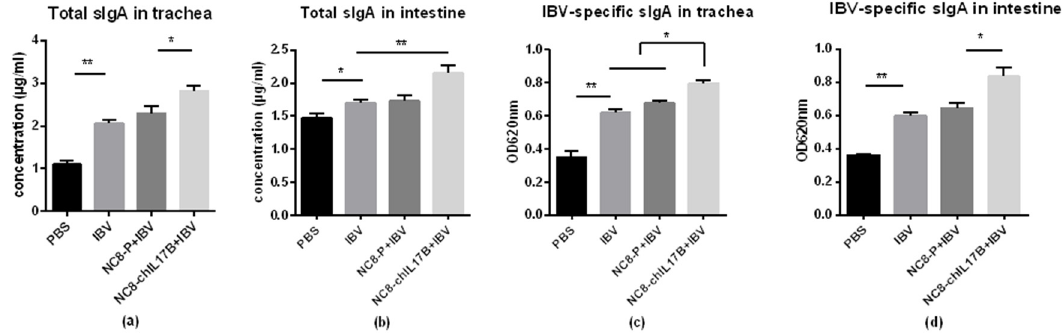
Figure 6. Results of the total sIgA concentrations ( a , b ) and the IBV-specific sIgA titers ( c , d ) in the tracheas and intestines, detected by ELISA. Concentrations and optical delnsity under 620 nm wavelength (OD 620 ) are shown as mean values + S.D. of each group. Tukey’s multiple comparison test was used for statistical analysis; * p < 0.05, ** p < 0.01.